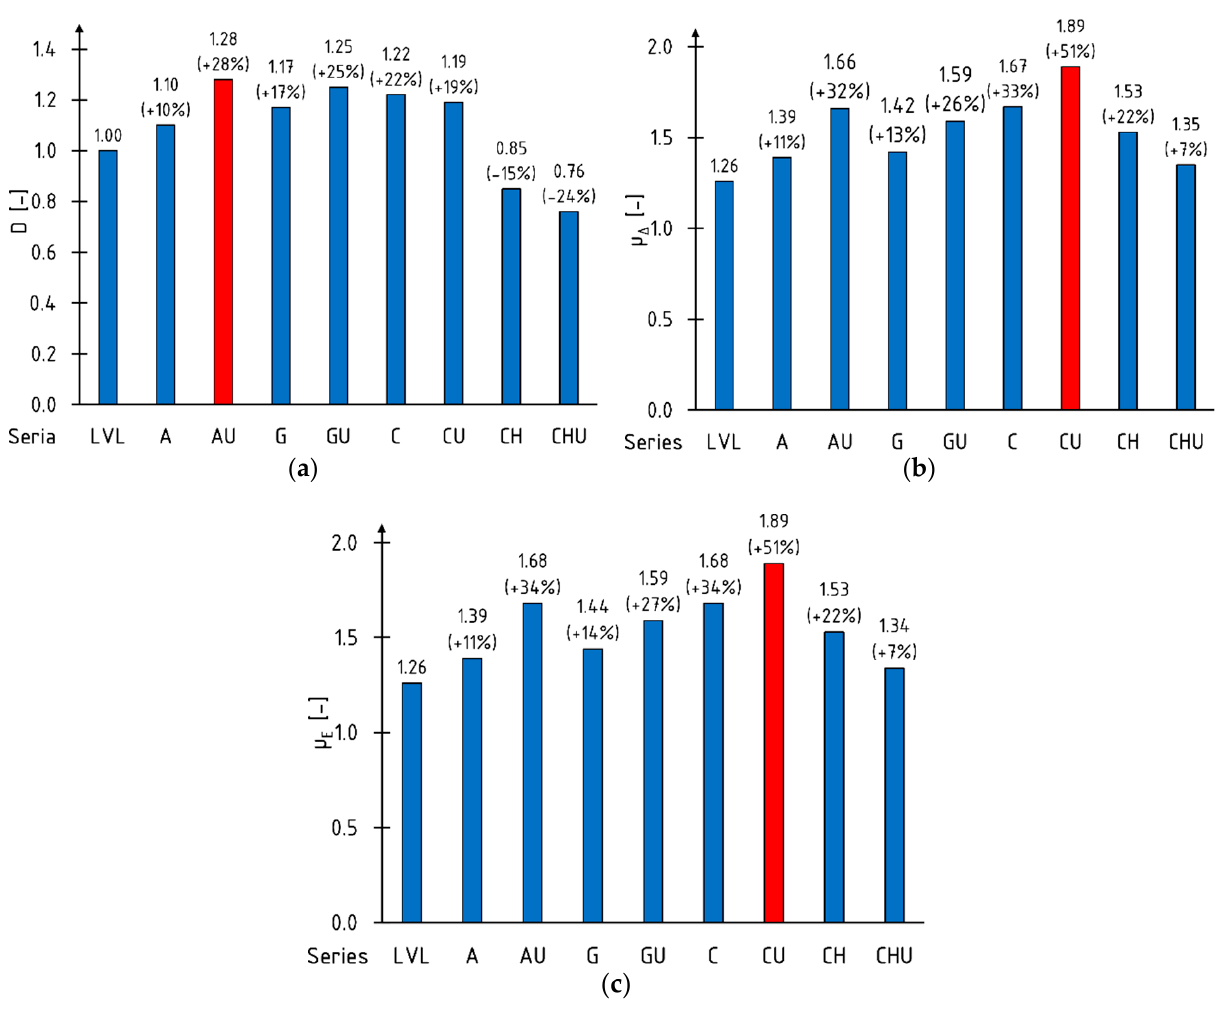
Table 5. Stiffness analysis.